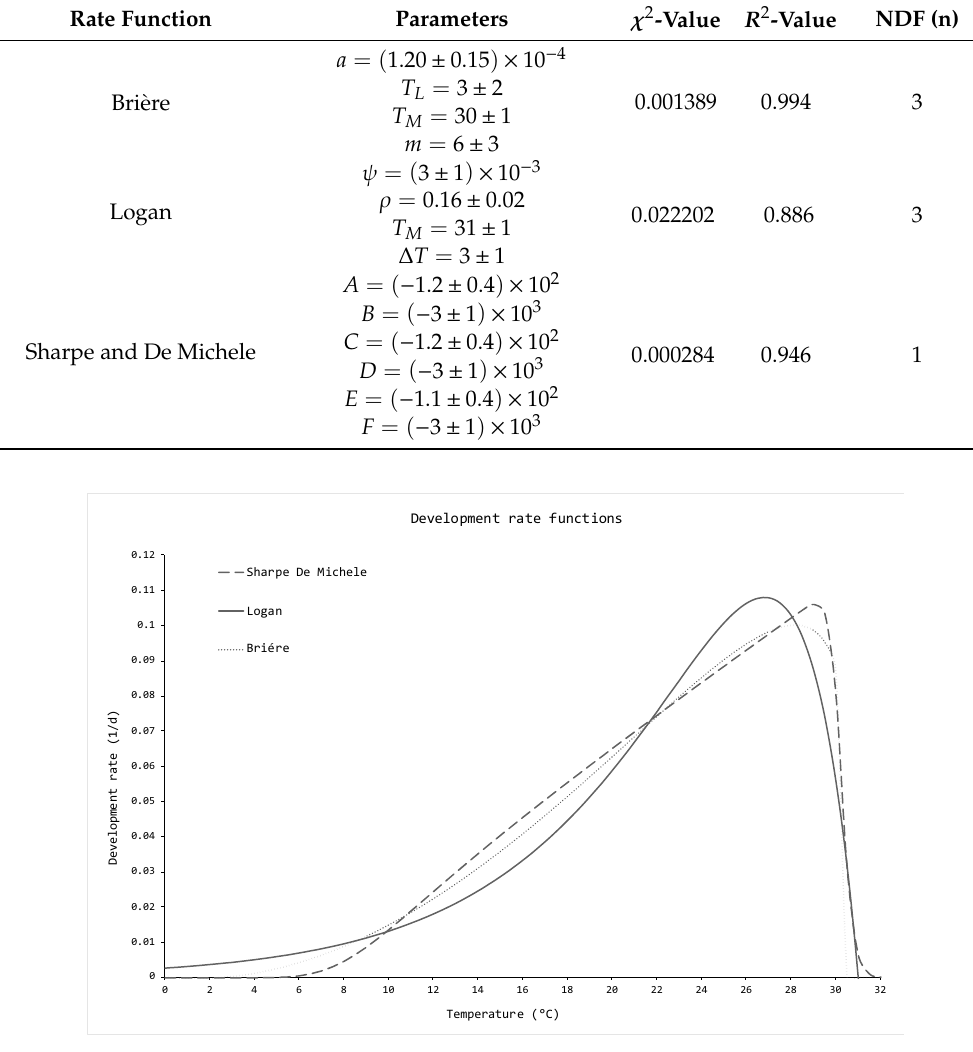
Figure 1. Graphical representation of Briére (3), Logan (4) and Sharpe and De Michele (5) best fit functions estimated with data from Tochen et al. [12]. Numerical values are available in Table 2.